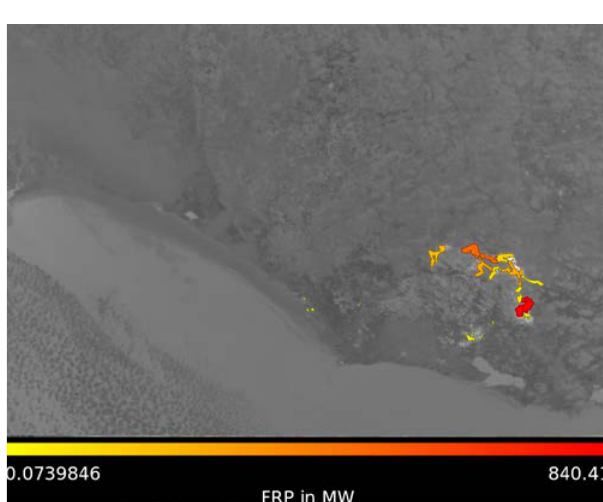
Figure 9 Northcliffe (West Australia) 8.2.2015 16:11UTC